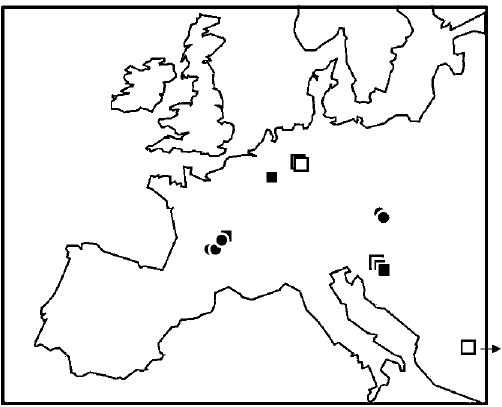
Figure 2. Geographical Origin of Neandertal and Early Modern Human Samples from Which mtDNA Sequences Have Been Analyzed Filled squares and filled circles represent Neandertal and early modern human remains, respectively, analyzed in this study. The four Neandertal remains formerly analyzed are represented by empty squares.